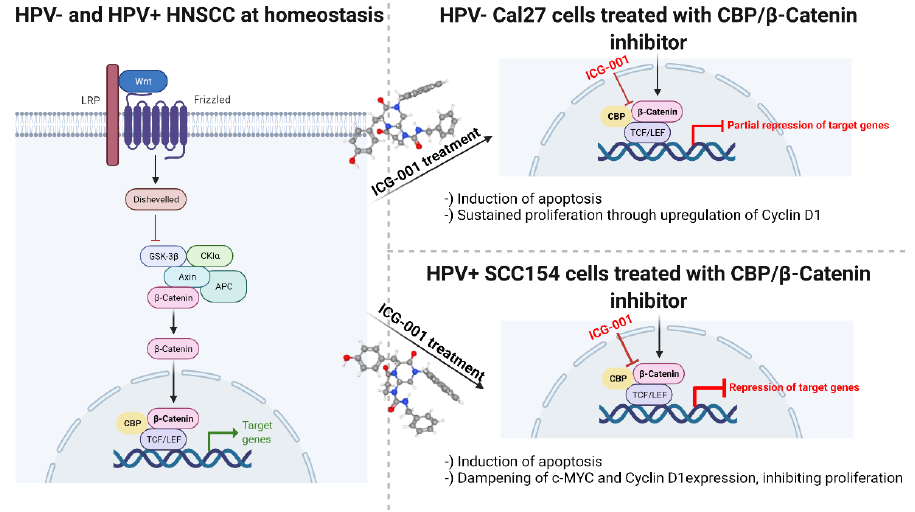
Figure 7. The mechanism of action of ICG-001 in HPV-negative and HPV-positive HNSCC cells. Schematic representation of WBC signaling at baseline (homeostasis) and the effects of CBP inhibition via ICG-001 (the molecular structure was retrieved from the publicly available and free reproducible source [16]) in HPV-negative and HPV-positive HNSCC tumor cells. The scheme was created with BioRender.com (accessed on December 30 th of 2021).